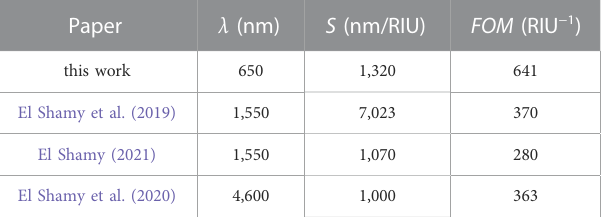
TABLE 1 Comparison of S and FOM at different wavelengths with previously reported work.